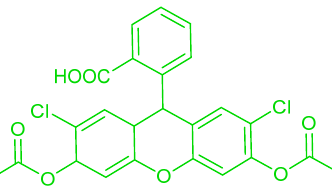
Figure 60. Structure of DCFA–DA by Zwolak et al.